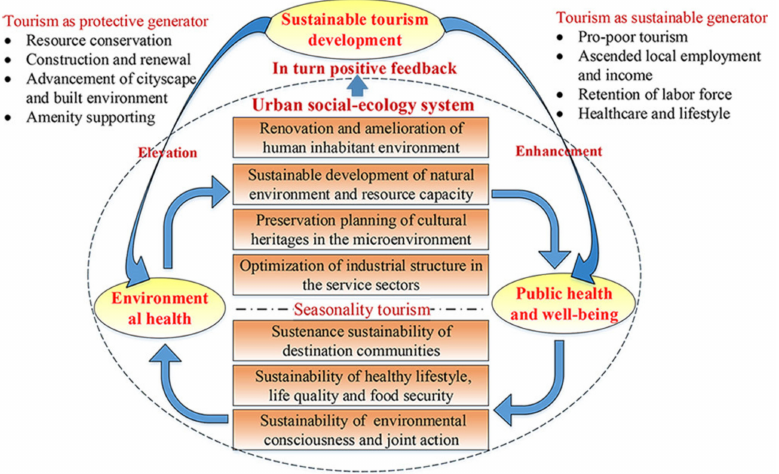
Figure 7. Synergistic relationships between Dunhuang’s tourism and social-ecology